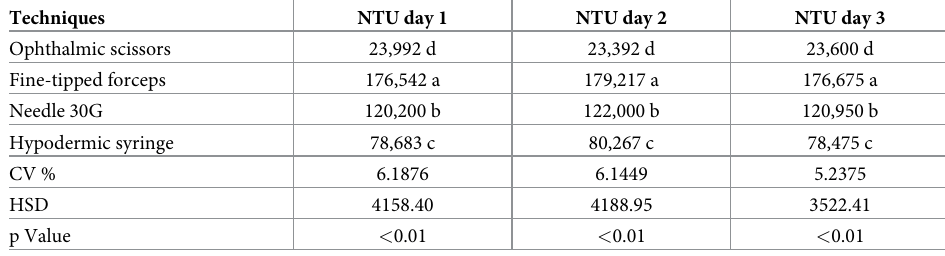
Table 1. Values of the turbidity measurements of the samples in NTU. Comparison between the three days of sam- ple collection tested in a turbidimeter, between the four different techniques used for the extraction of hemolymph. Means followed by the same letter in the column did not differ statistically by Tukey’s test at a 1% probability of